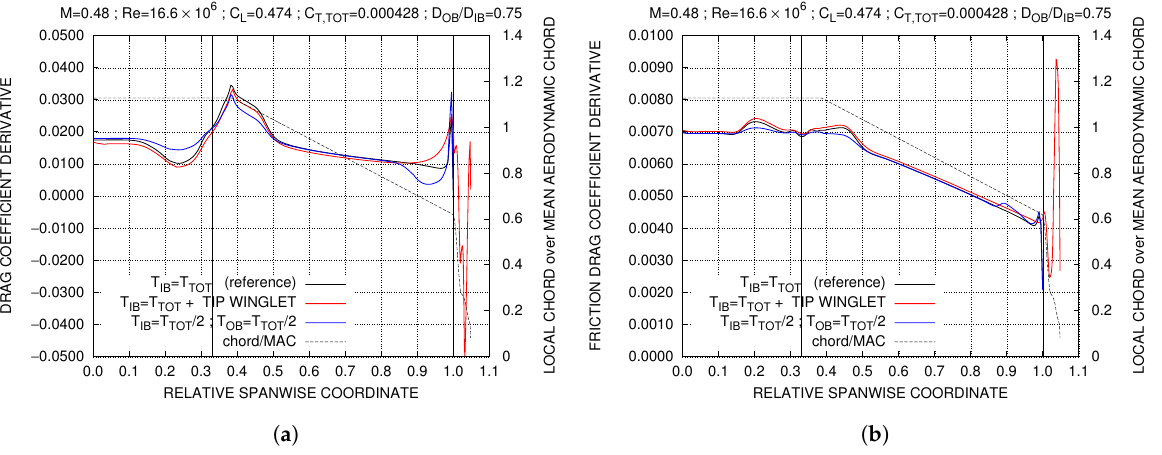
Figure 30. Comparison of wing spanwise loading with tip winglet or tip propeller, against reference configuration, in cruise flight conditions: ( a ) total drag coefficient derivative; ( b ) friction drag coefficient derivative.